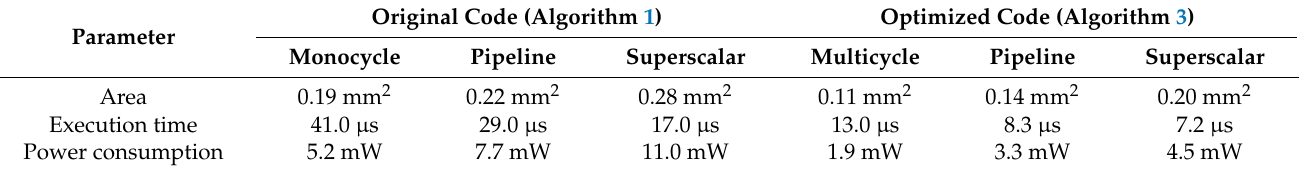
Table 4. Results for customized ASIP versions generated by ASIPAMPIUM for the cosine function using Taylor